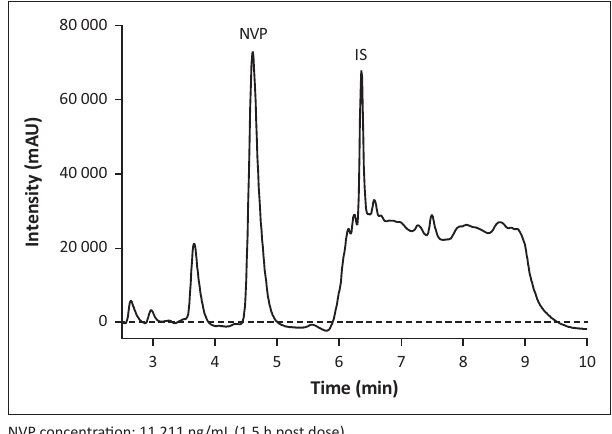
FIGURE 5: Chromatogram overlay of LLOQ with herbs, no interference at nevirapine and internal standard retention times was observed in all herbs.